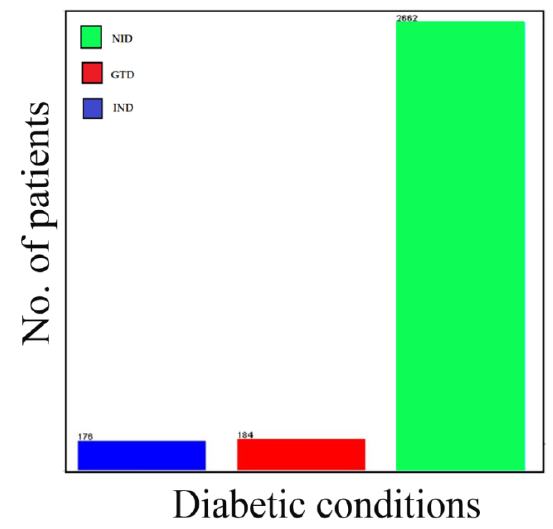
Figure 4. Bar flow for the patient’s diabetic condition.